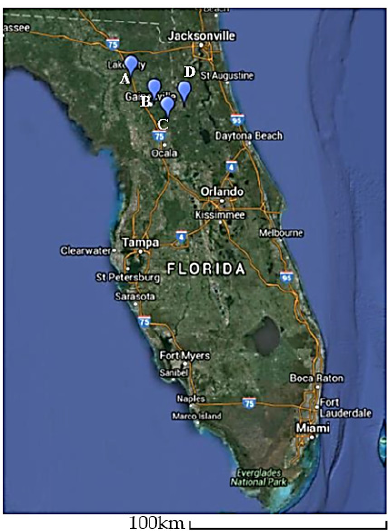
Figure 1. Map showing the locations of the collected blueberry samples. Adapted from [5]. (A) O’leno State Park, High Springs; (B) Morning Side Nature Center, Gainesville; (C) Island Grove; (D)